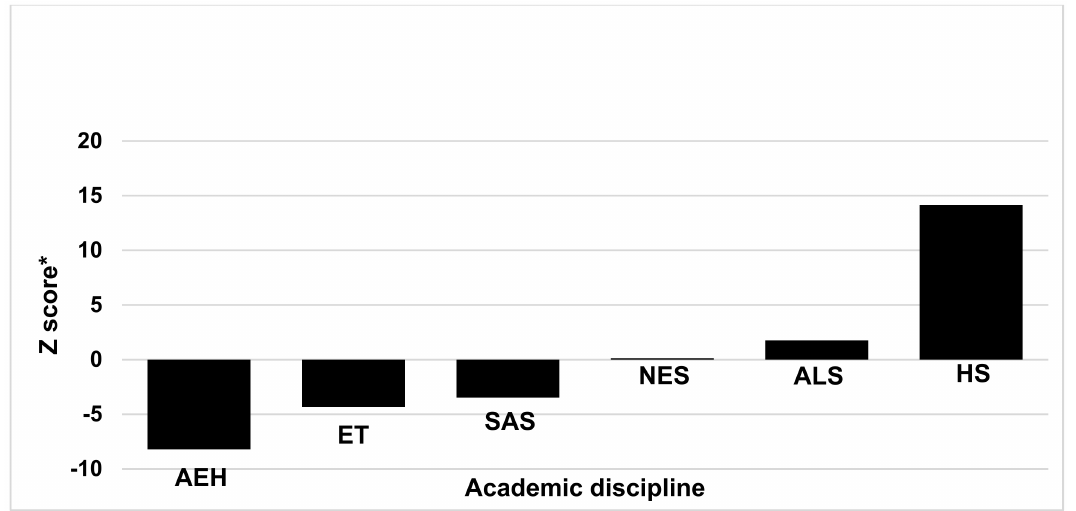
Figure2. Rankingofschools’healthpromotionneedsbyacademicdiscipline( N = 26). *Ahighernegative Z-score indicates higher priority. AEH, Arts, Education and Humanities; ALS, Agricultural Sciences; HS, Health Sciences; NES, Natural and Exact Sciences; SAS, Social and Administrative Sciences; ET, Engineering and